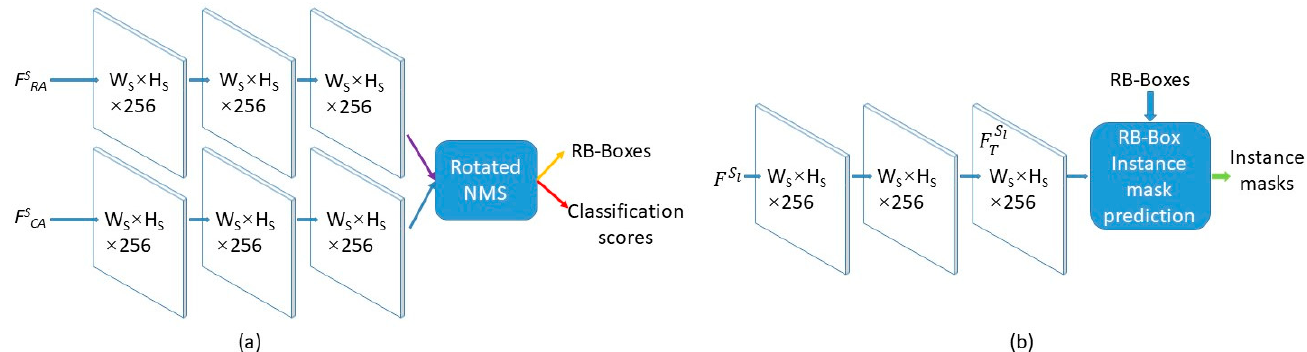
F and S F are input into and F S are input into two CA RA RA CA S F as input,